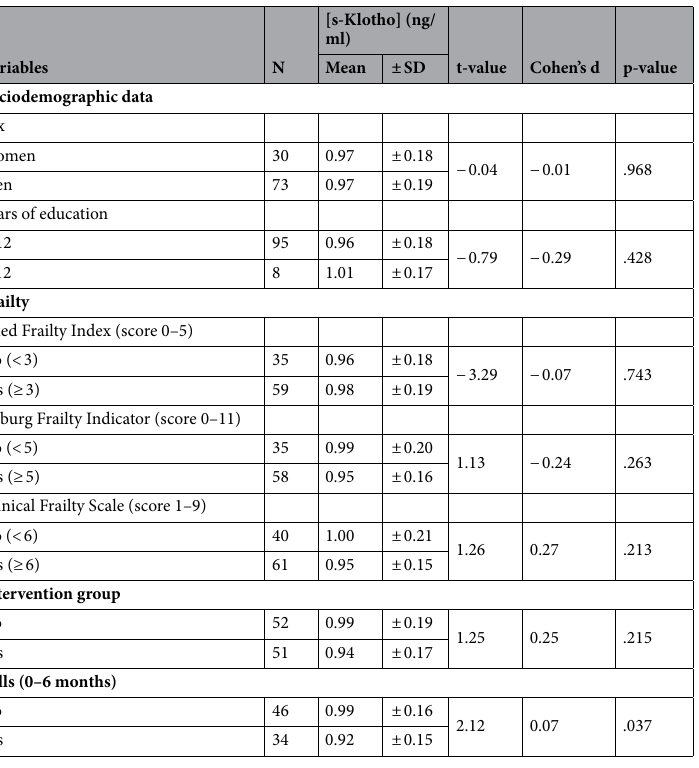
Table 3. Student’s t-test comparing s-klotho concentrations in groups based on sex, years of education, frailty status, participation in the exercise program and falls. SD standard